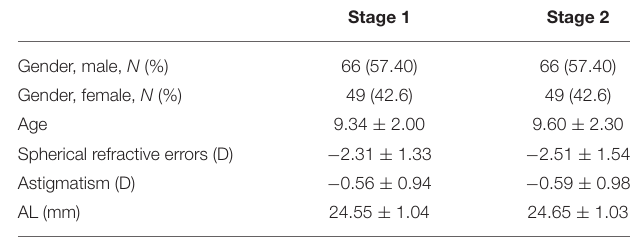
TABLE 1 | Baseline characteristics of different